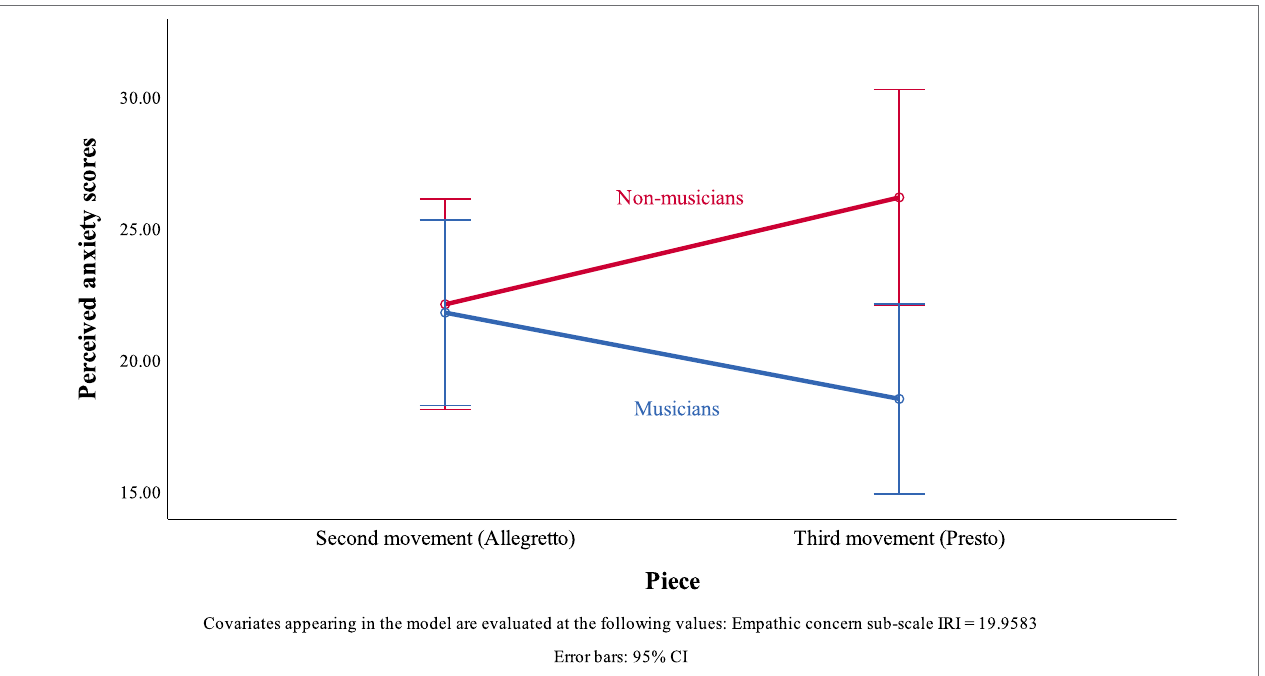
FIGURE 3 | Interaction effect of piece performed and musical